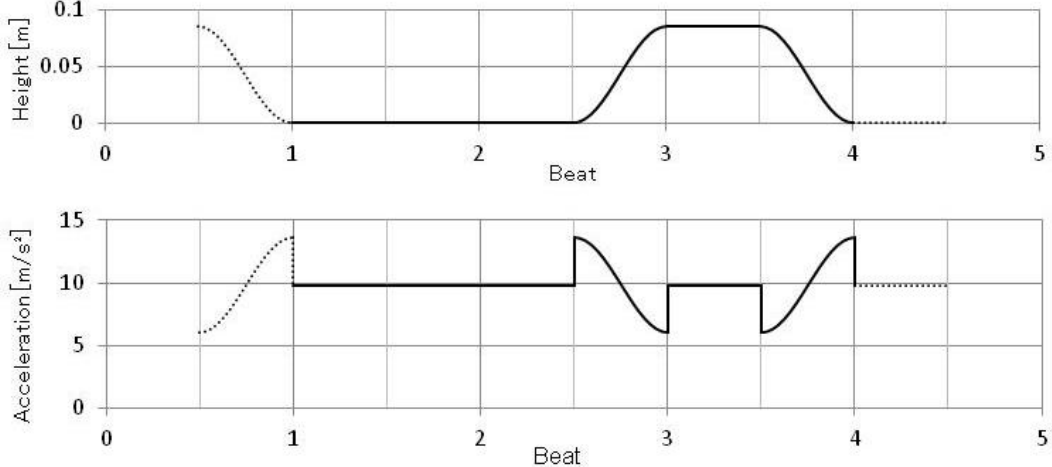
Figure 2. Rise and Fall of 1–3 of Spin Turn in Waltz. The upper graph shows the height and the lower graph shows its acceleration in vertical direction. The dotted lines show an example of preceding and following